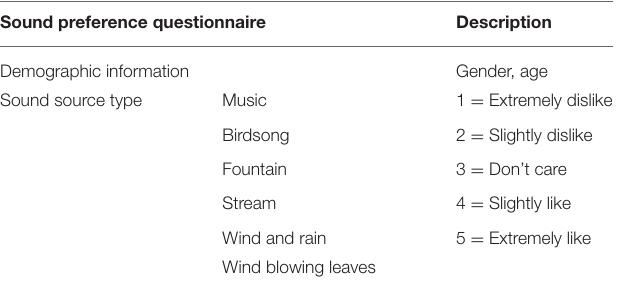
TABLE 1 | Contents of the sound preference questionnaire for older adults with